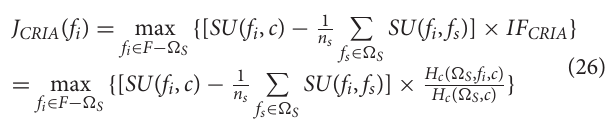
TABLE 2 | Datasets for comparison between CRIA algorithm and other